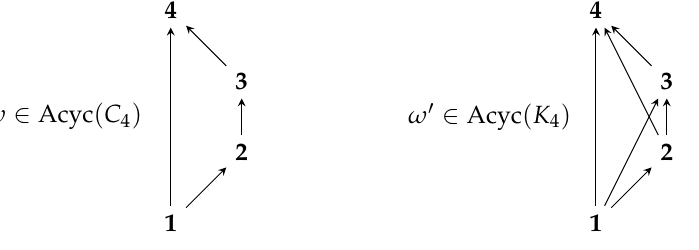
Figure 3. Despite the equality P ( C 4 , [ ω ]) = P ( K 4 , [ ω (cid:48) ]) , the set I = { 1,3 } lies on a toric directed path 1 → tor 3 in ω (cid:48) but not for any representative of [ ω ]